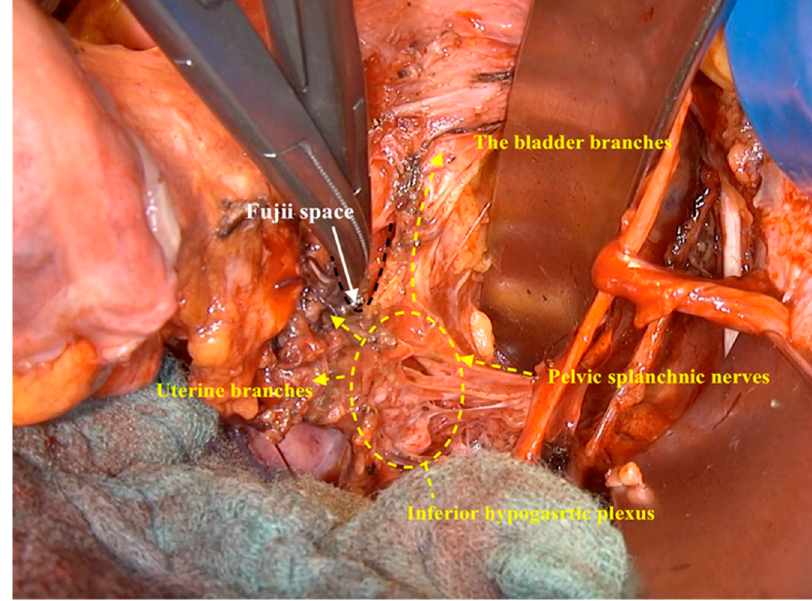
Figure 9. The dissection of the Fujii space to isolate the inferior hypogastric plexus from the lateral vaginal wall.